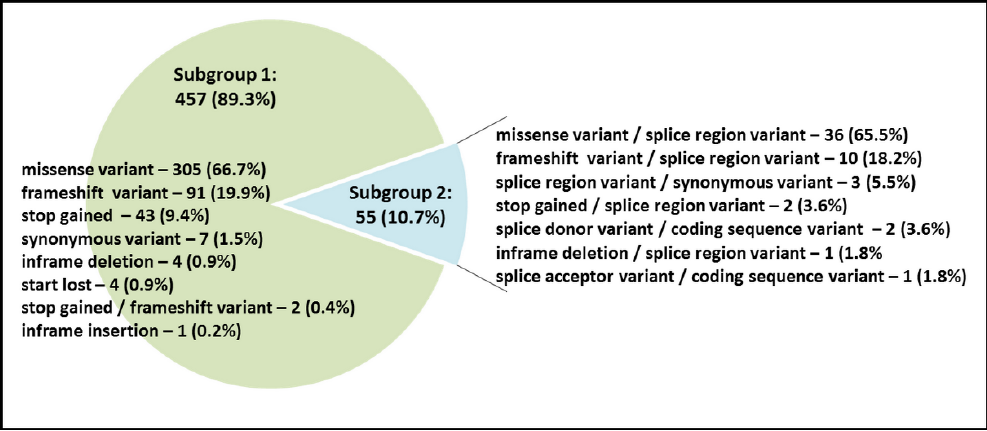
Figure 2. The distribution of PLP variants located in the SLC26A4 coding region according to their molecular consequences.